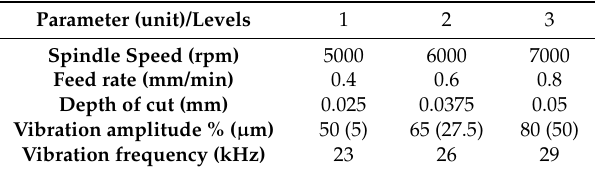
Table 2. RUM parameters and their